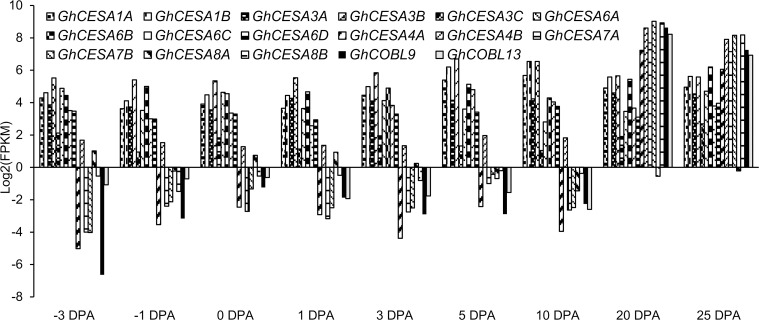
Expression patterns of GhCOBL9 and GhCOBL13 with the GhCESA family genes in G. hirsutum acc. TM-1.The X axis indicated the different fiber development stages and the Y axis indicated the expression levels.